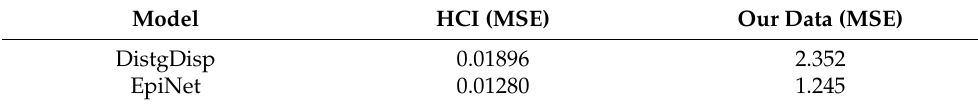
Table 2. Disparity estimation results comparision between HCI dataset and uur